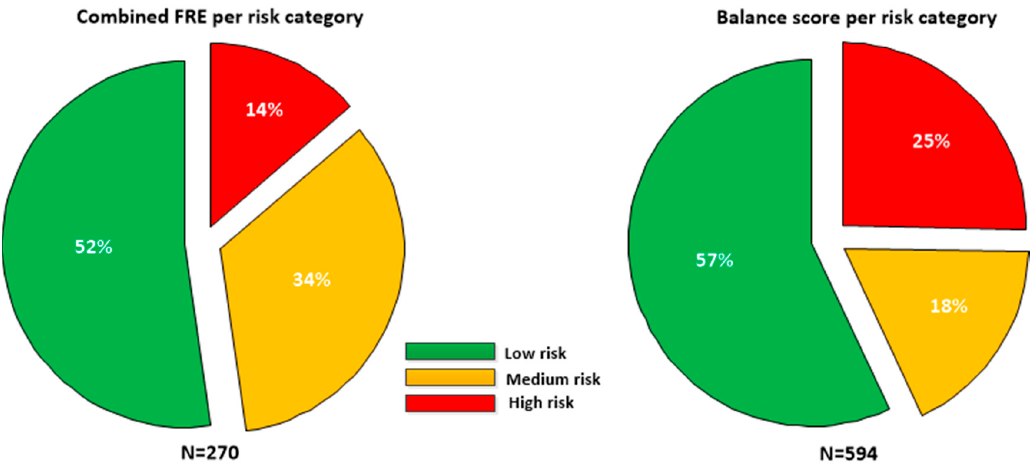
Figure 2. Falls risk estimate ( FRE combined , N = 270) and balance scores (N = 594) broken down in low, medium and high risk categories for the sample. As the FRE is only defined for patients greater than 60, a smaller sample was available than for the Balance score which is defined for all age groups.